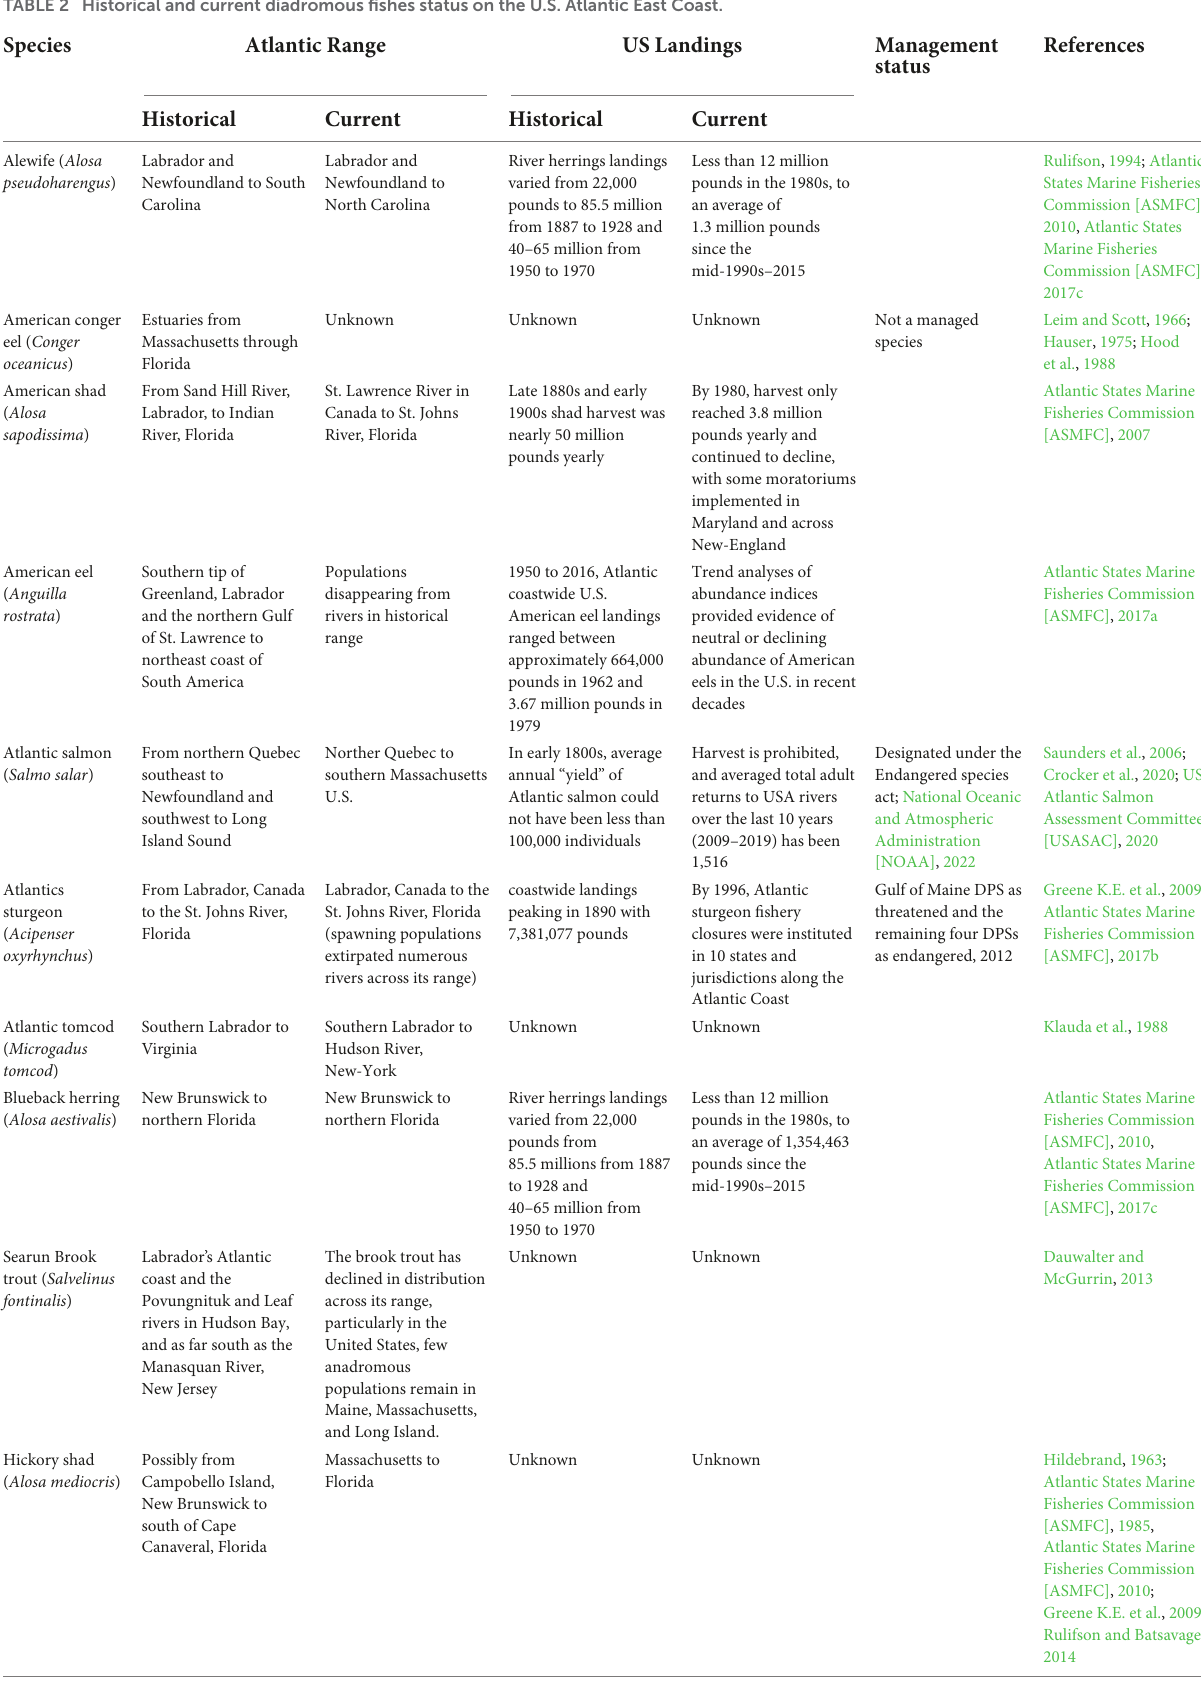
TABLE 2 Historical and current diadromous fishes status on the U.S. Atlantic East